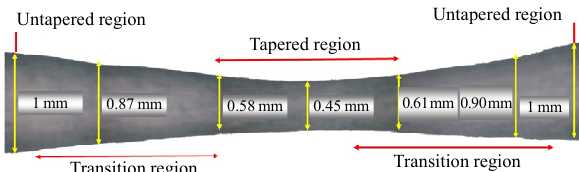
Fig. 1 Microscopic image of the tapered plastic optical fiber and its regions.